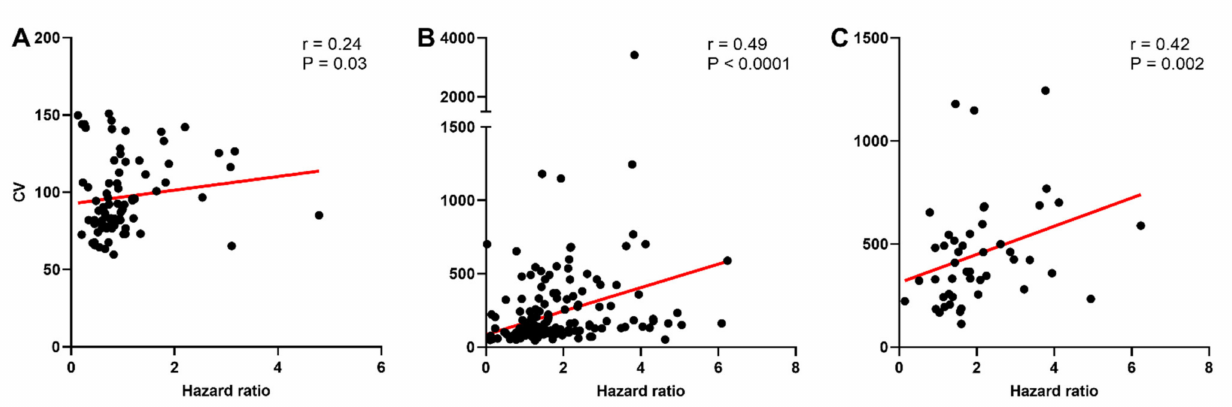
Figure 5. Variability of spike firing in oxytocin and vasopressin neurons in non-pregnant, late-pregnant, and lactating rats. ( A – C ) Scatter plots of the coefficient of variation of inter-spike interval (CV) against peak early/mean late hazard ratio in oxytocin neurons ( A ), vasopressin neurons ( B ), and phasic vasopressin neurons ( C ) from non-pregnant, late-pregnant, and lactating rats. There was a significant correlation between the CV and hazard ratio for oxytocin neurons (Spearman rank order correlation coefficient, r = 0.24, p = 0.03), for vasopressin neurons ( r = 0.49, p < 0.001), and for phasic vasopressin neurons ( r = 0.43, p = 0.002). Regression lines are shown for illustrative purpose